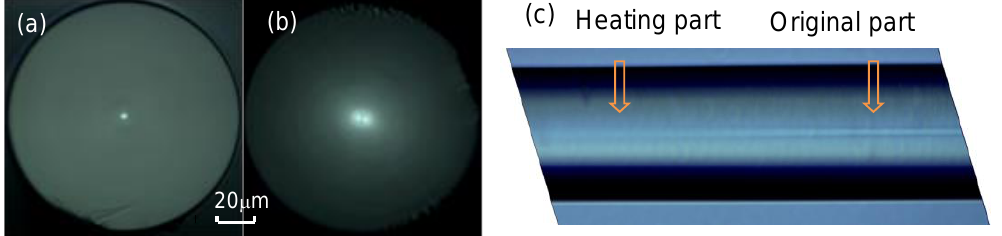
Figure 6. Cross-section of an ( a ) unheated and ( b ) heated UHNA-7 fiber, measured with a microscope. ( c ) Side image of LPFG which shows the heated and unheated part.